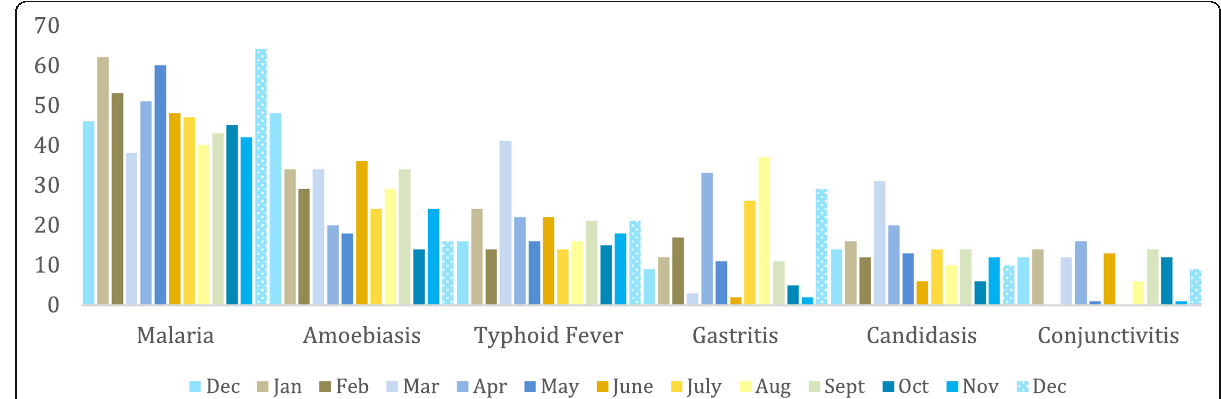
Fig. 3 Rumuruti district hospital admission from December 2013 – December 2014. * The different seasons are illustrated in different colours. Blue shades are used for months in the rainy season. Orange and brown shades are used for months in the dry